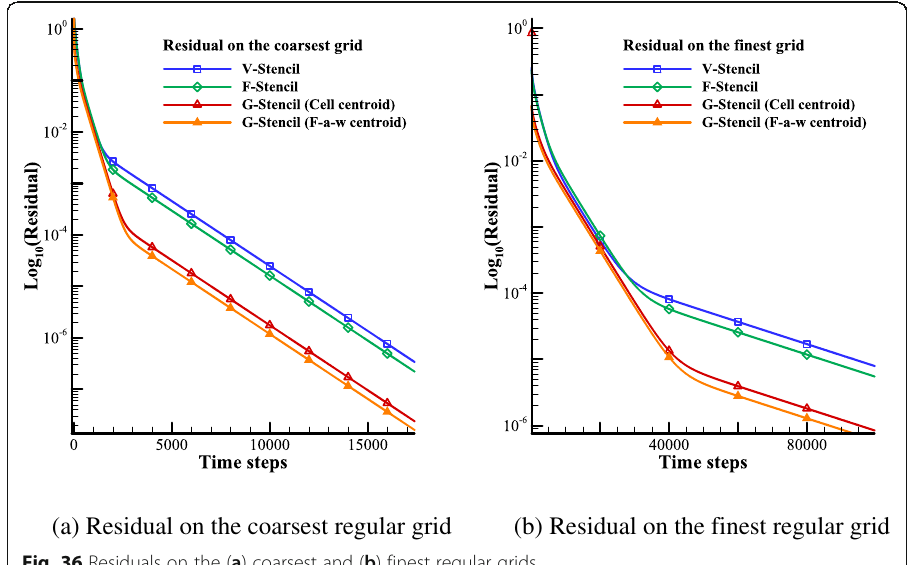
Fig. 36 Residuals on the ( a ) coarsest and ( b ) finest regular